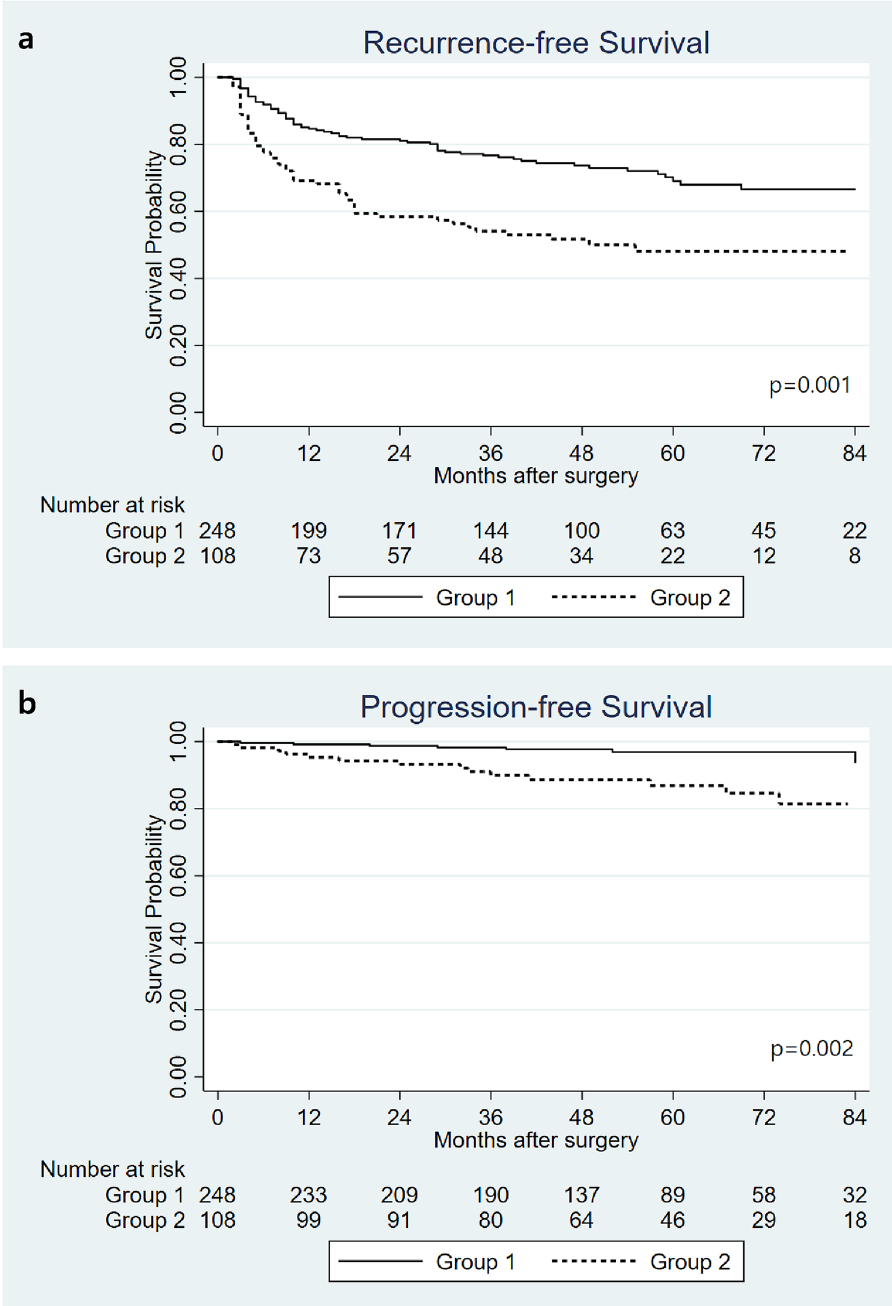
Figure 1. Kaplan–Meier curves for recurrence-free survival ( a ) and progression-free survival ( b ) in group 1 (prostate volume ≤ 30 mL) and group 2 (prostate volume > 30 mL) before propensity score